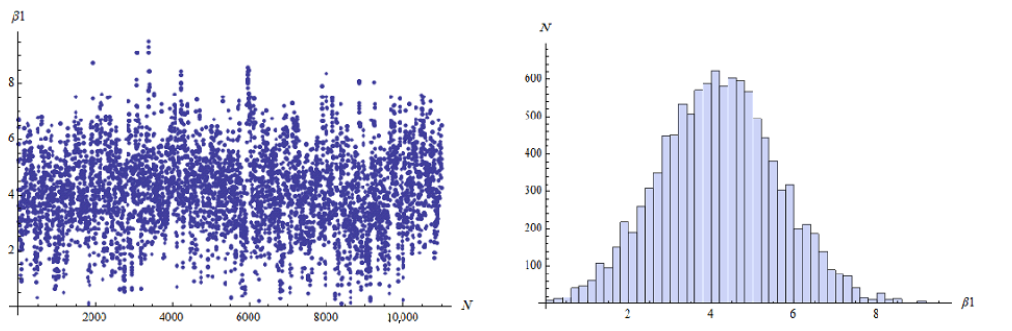
Figure 6. Trace ( Left ) and histogram ( Right ) plots of the parameter β 1 .